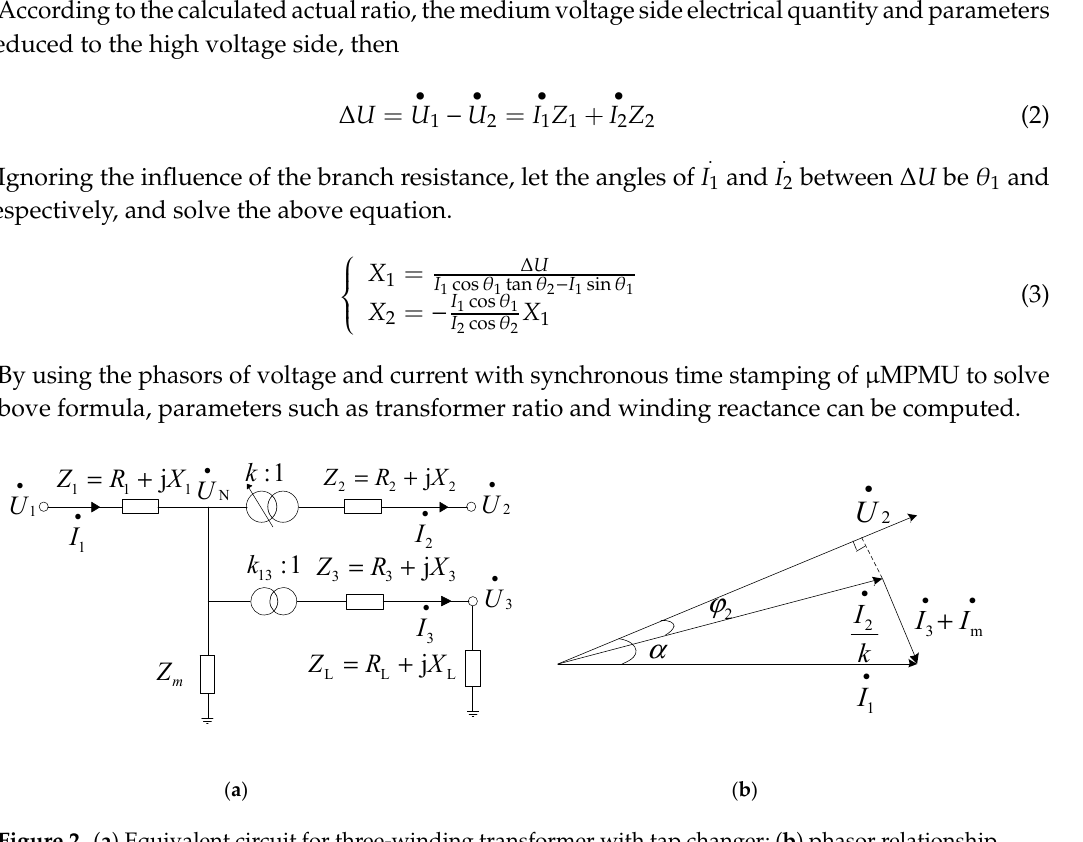
Figure 2. ( a ) Equivalent circuit for three-winding transformer with tap changer; ( b ) phasor relationship of three-winding transformer.